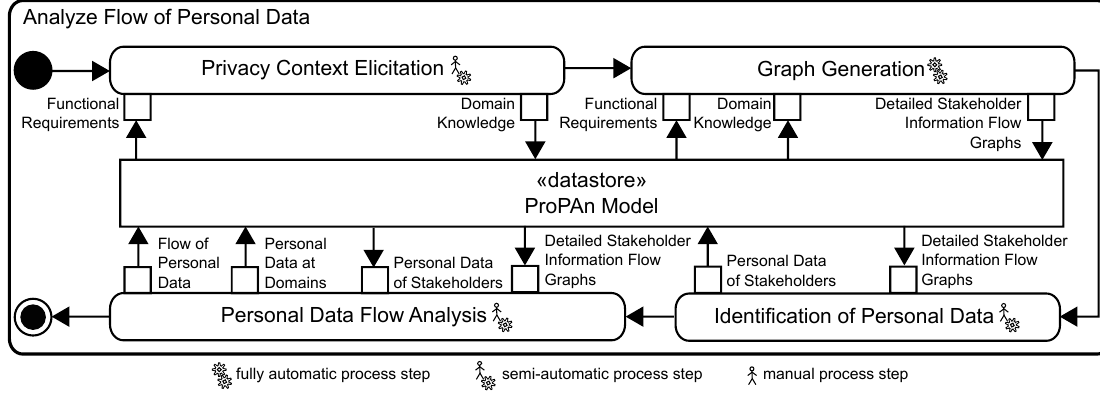
Figure 4. Refinement of the step Analyze Flow of Personal